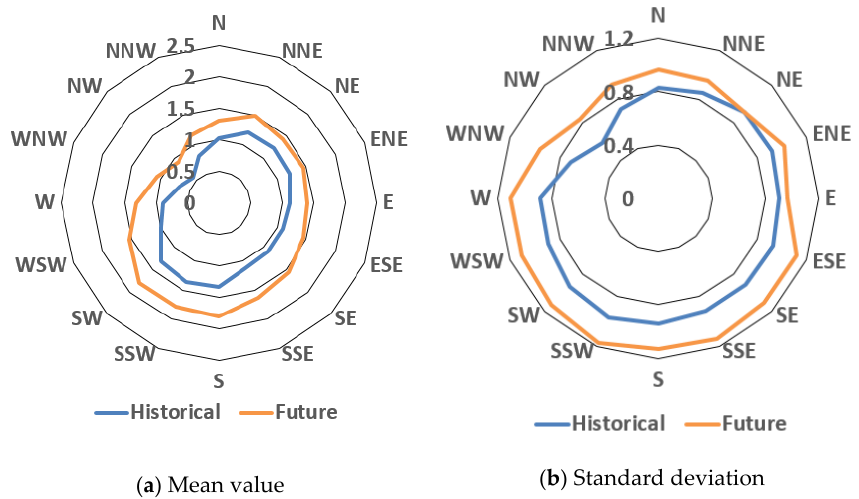
Figure 16. Mould growth index (2-year’s average) for different orientations at